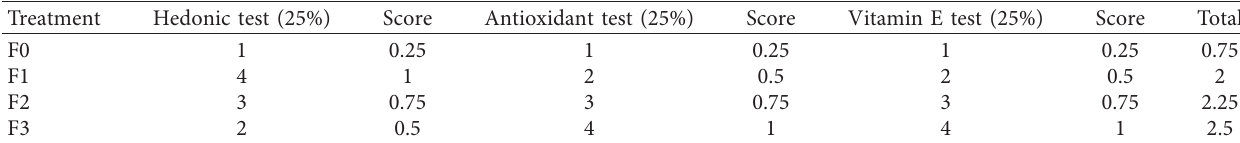
Table 8: Determination of selected formulation score.